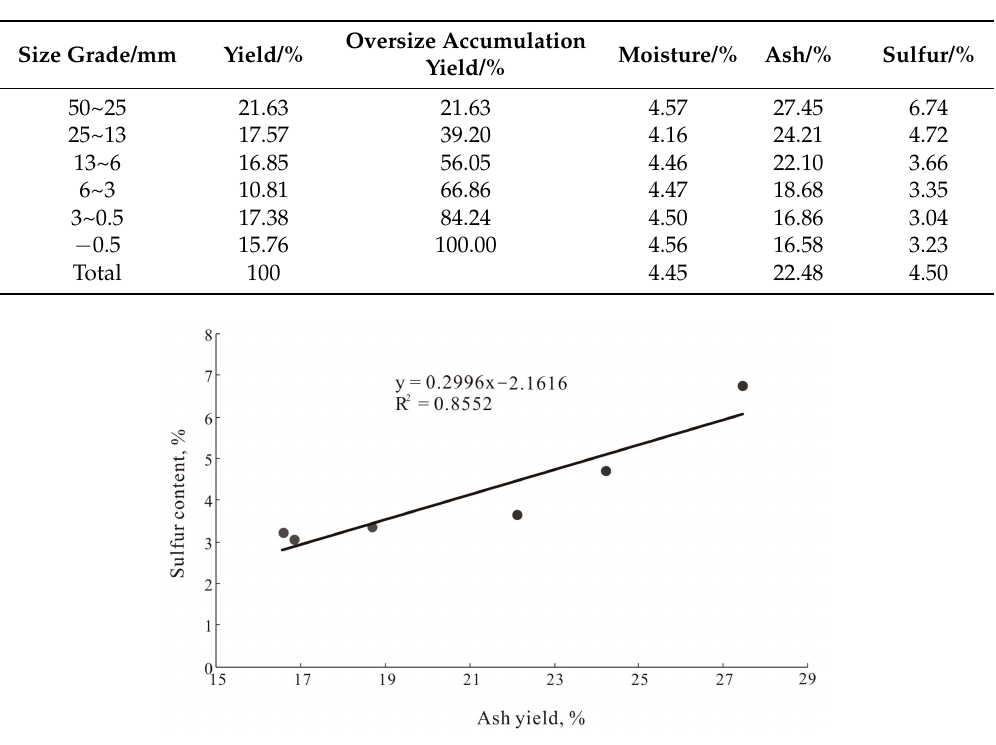
Table 1. Size distribution and contents of moisture, sulfur, and ash yields of each size fraction.